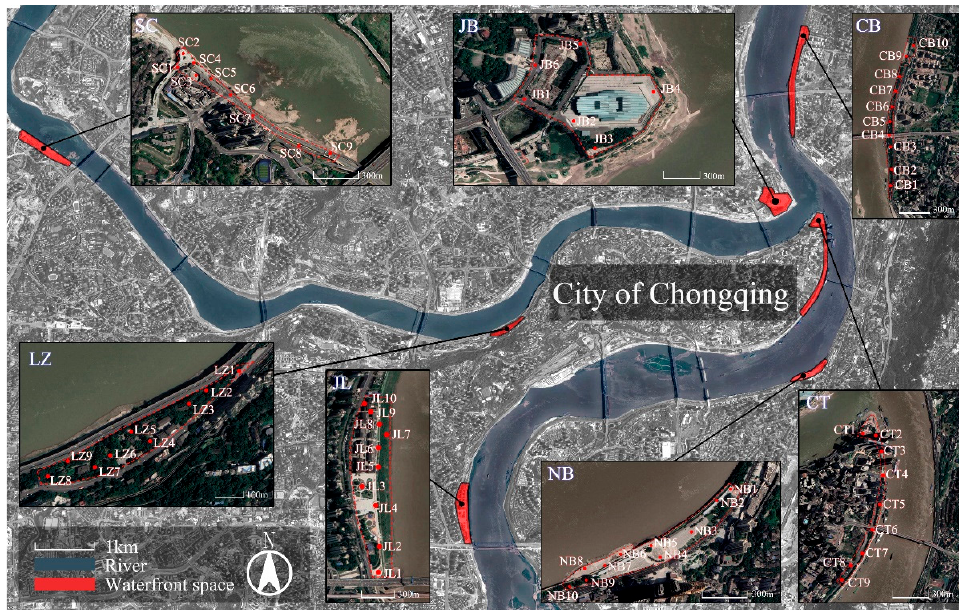
Figure 1. Plans of the seven studied WSMCs and the locations of walking points in Chongqing. WSMC = waterfront space in mountainous cities. Table 1. Basic information on the seven WSMCs.